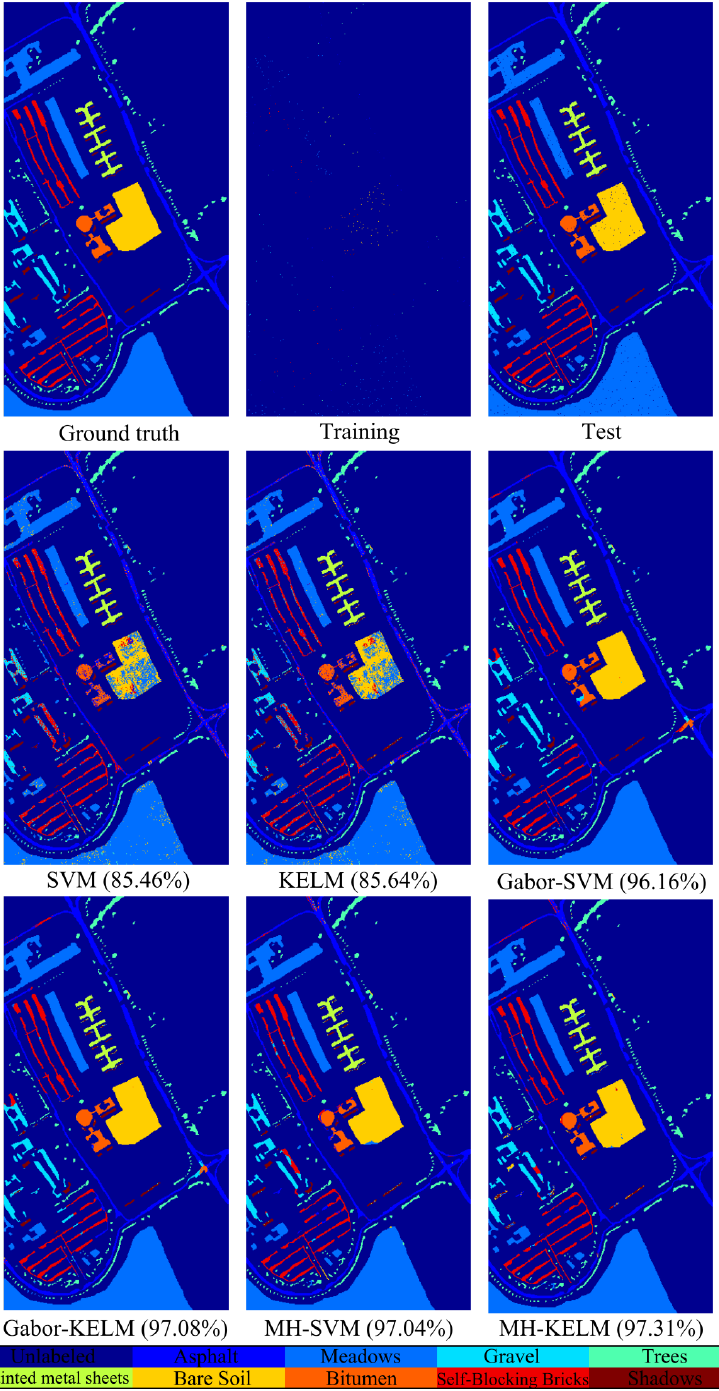
Figure 8. Thematic maps resulting from classification using 423 training samples (1% per class) for the University of Pavia dataset. The overall classification accuracy of each algorithm is indicated in